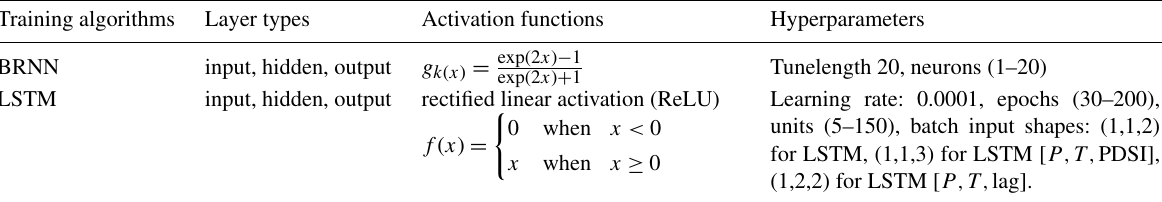
Figure A1. Structure of LSTM neural network model in a Keras environment for runoff predictions. Table A1. Structure and hyperparameters of two data-driven models (BRNN and LSTM) for runoff